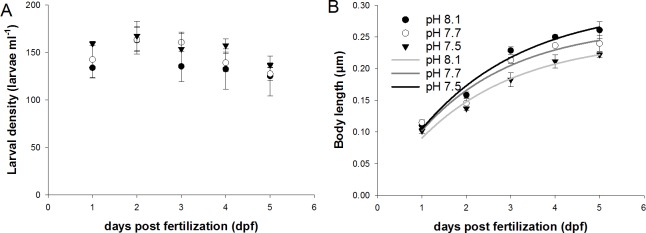
Mortality and growth of sea urchin larvae raised under different pH treatments.(A) Larval densities were constant at 140 to 160 larvae per ml over the experimental duration of 5 days. No effects on the larval densities were observed between the three pH treatments. Larval growth expressed as body length (BL) followed a logarithmic curve along the period of 5 days. Regression analyses demonstrated significant differences in BL between the three pH treatments. Values are presented as mean ± SD.